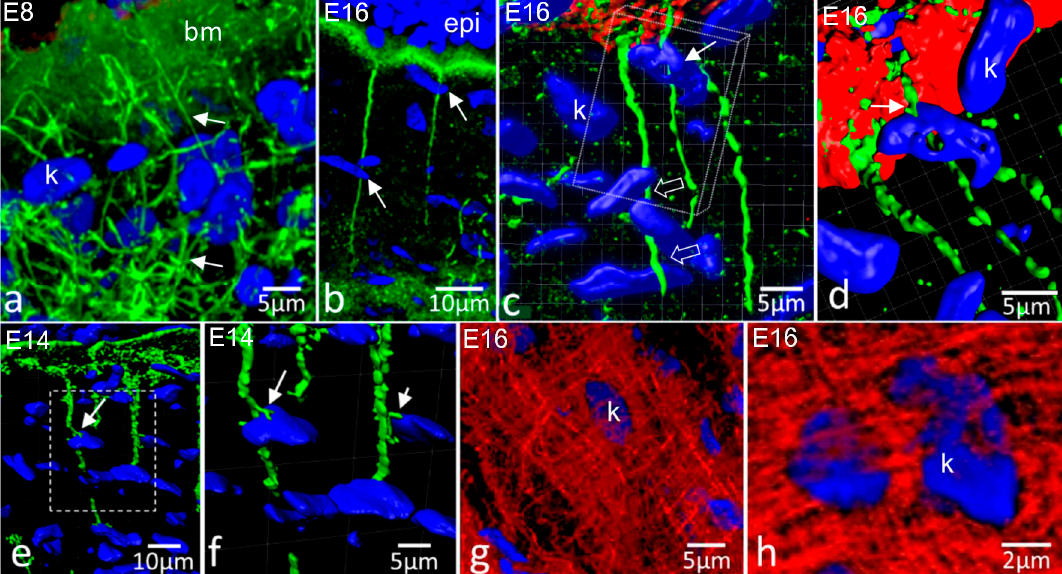
Figure 4. Fibronectin (green) and tenascin-C (red) interactions with keratocytes. bm, basement membrane; k, keratocyte nucleus; epi, epithelium. ( a ) E8 cornea, fibronectin label. 3D projection showing fibronectin cords/strings form links between keratocytes and between keratocytes and the epithelial basement membrane (bm; green sheet at upper part of image); ( b ) E16 cornea, fibronectin label. Fibronectin strings (arrowhead) pass into the stroma and run close to keratocytes, as shown by the presence of keratocyte nuclei near strings (arrows); ( c ) E16 cornea, dual label. Imaris 3D surface projection from dataset shown in ( b ), with tenascin-C channel added and dataset enlarged and tilted. Fibronectin strings pass very close to keratocyte nuclei (arrow) and, towards the bottom of the figure, a strand can be seen passing through a cluster of three keratocyte nuclei, running below the upper two and above the lowest (open arrows). The boxed volume is rotated and shown in ( d ); ( d ) Enlargement of the boxed region indicated in ( c ). The upper nucleus, as indicated by the white arrow in ( c ), is hooked around the fibronectin string (arrow). In addition, fibronectin strings can be observed emerging through the tenascin-C-rich Bowman’s layer (red); ( e , f ) E14 cornea, fibronectin label and Imaris 3D surface projections; ( f ) is an enlargement of the boxed region in ( e ). Fibronectin strings pass into the stroma from the basement membrane (top of image) into the stroma. Where keratocytes are encountered, as shown by their nuclei, small side branches of the fibronectin strings associate with them (arrows); ( g , h ) E16 cornea, en face section with tenascin-C label at medium and high magnification, respectively. Keratocytes, as shown by their nuclei, are closely embedded within the tenascin-C